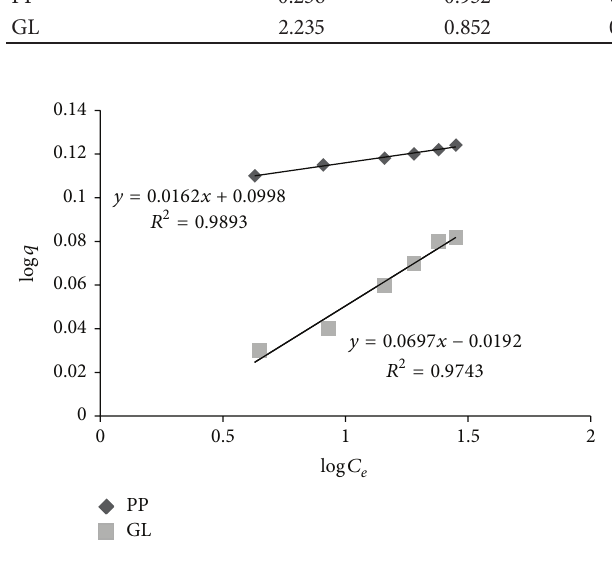
Figure 15: Freundlich isotherm model. Table 7: Adsorption isothermal parameters of Freundlich isotherm.